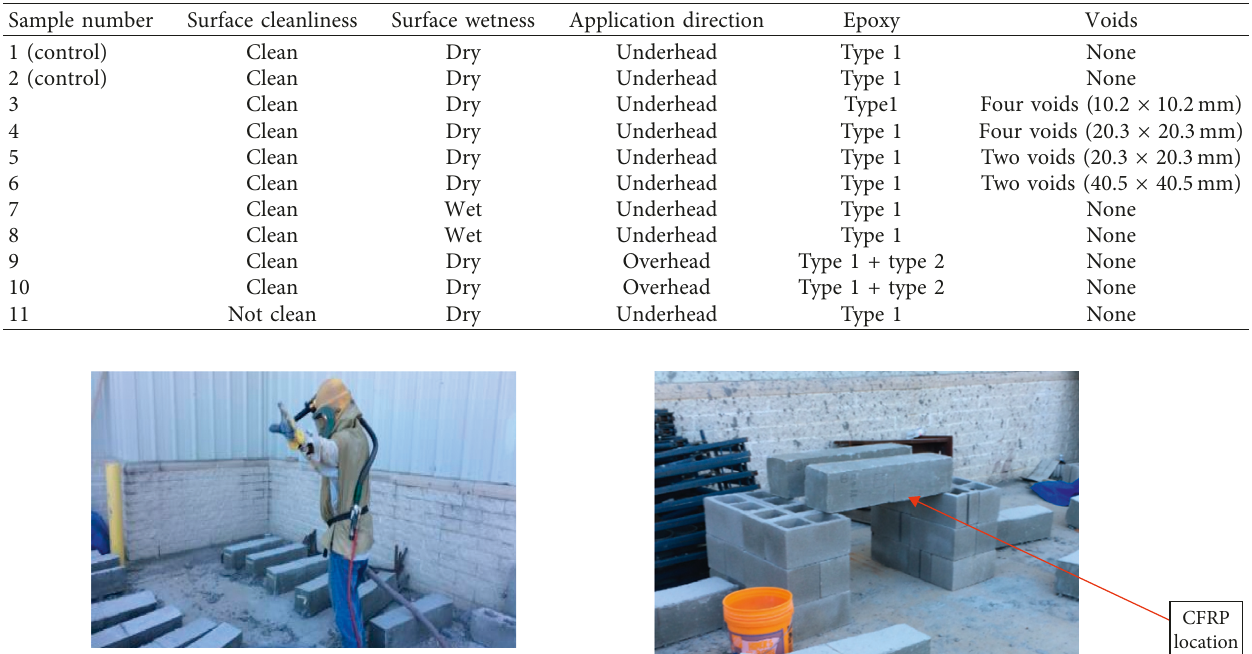
Table 5: Test matrix.